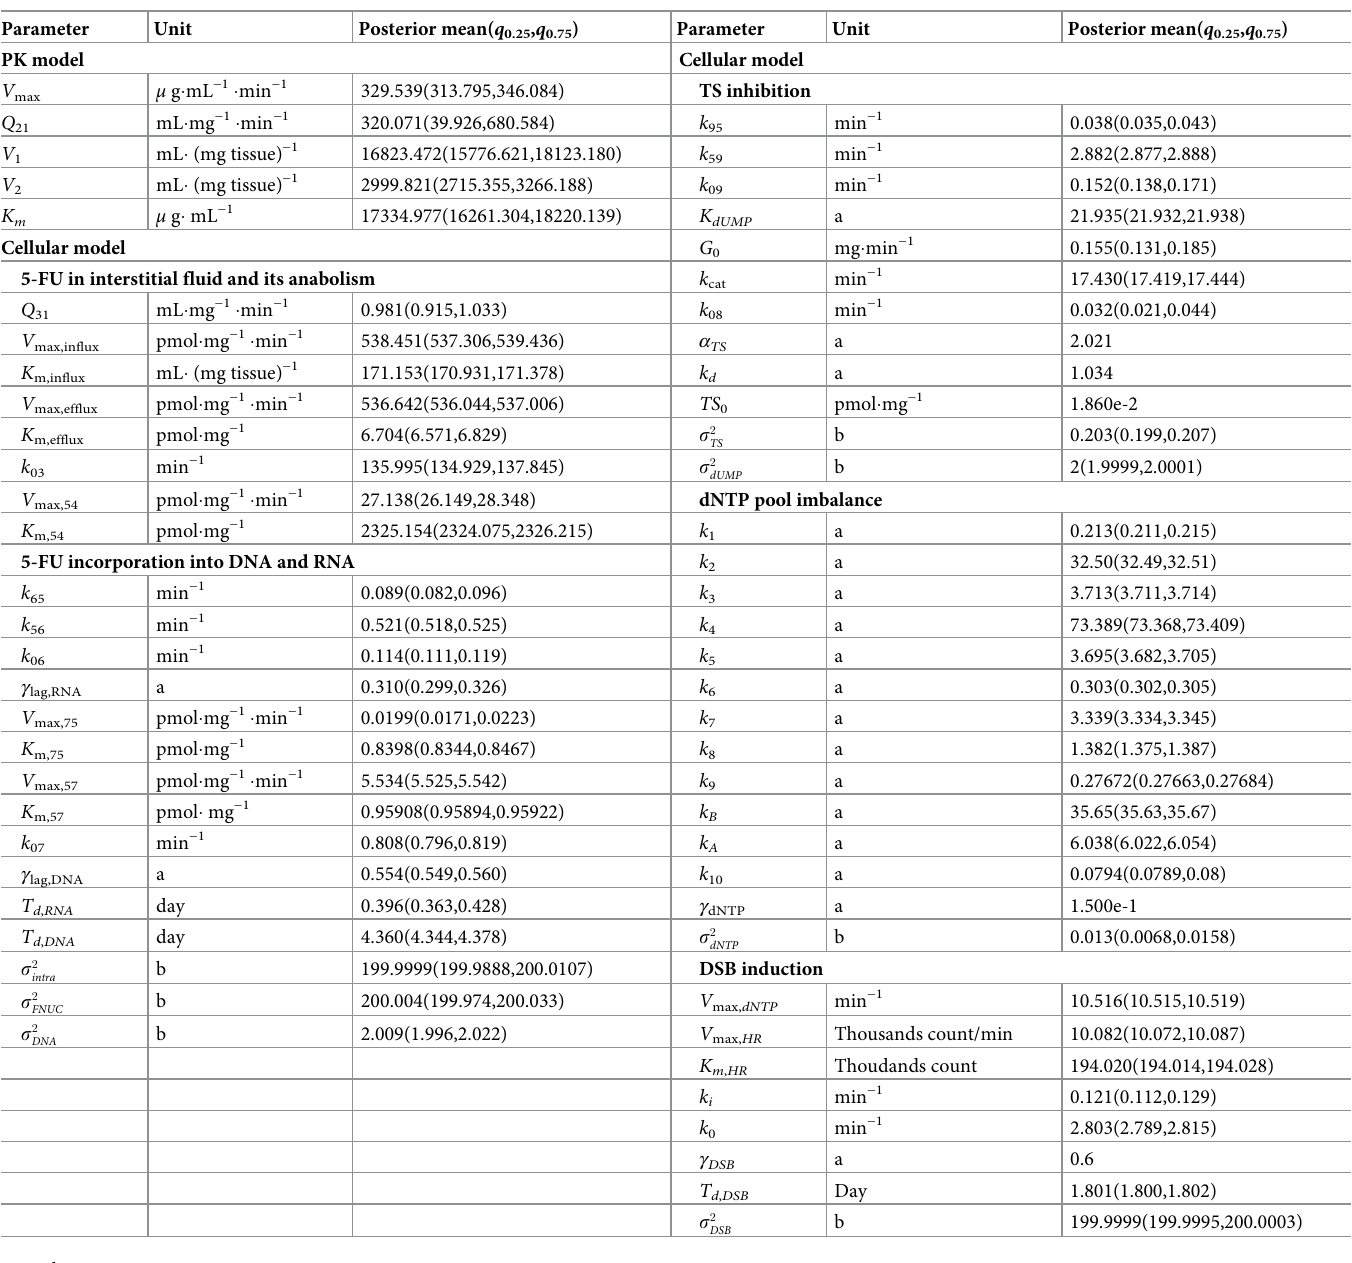
Table 1. Parameter estimates for PK and cellular